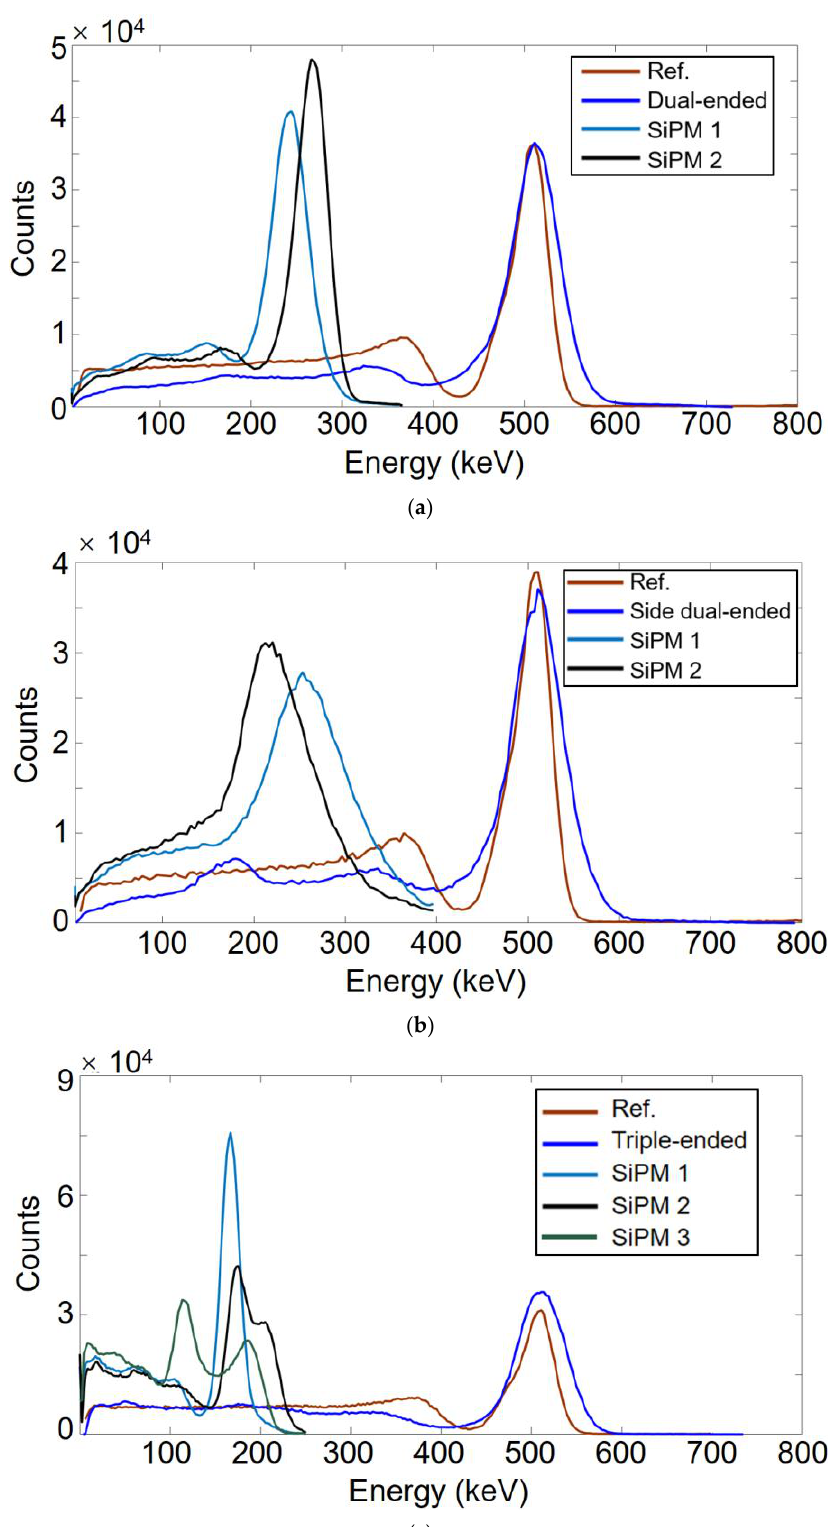
Figure 7. Energy spectra of ( a ) dual-ended, ( b ) side dual-ended, and ( c ) triple-ended readout experiment.